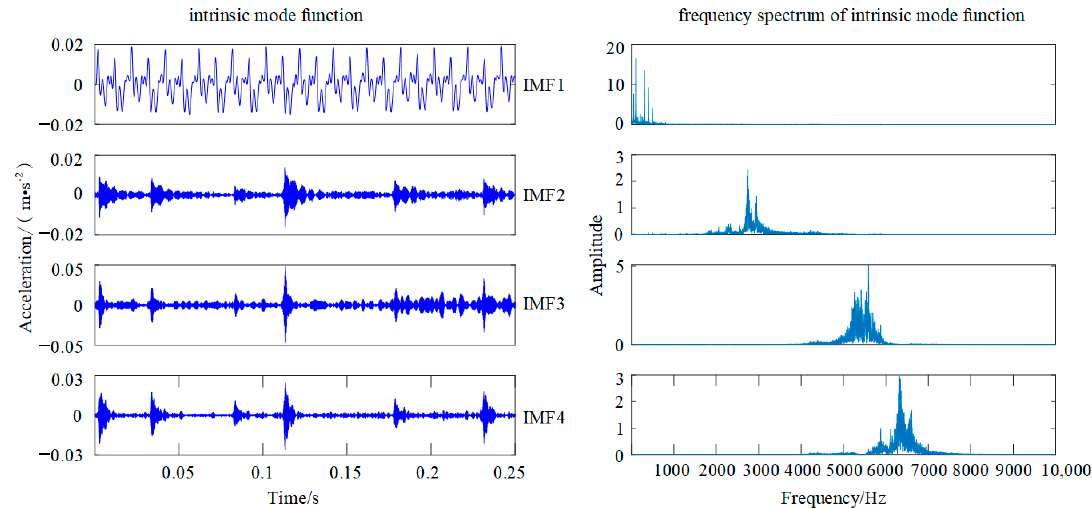
Figure 7. Original VMD decomposition diagram.